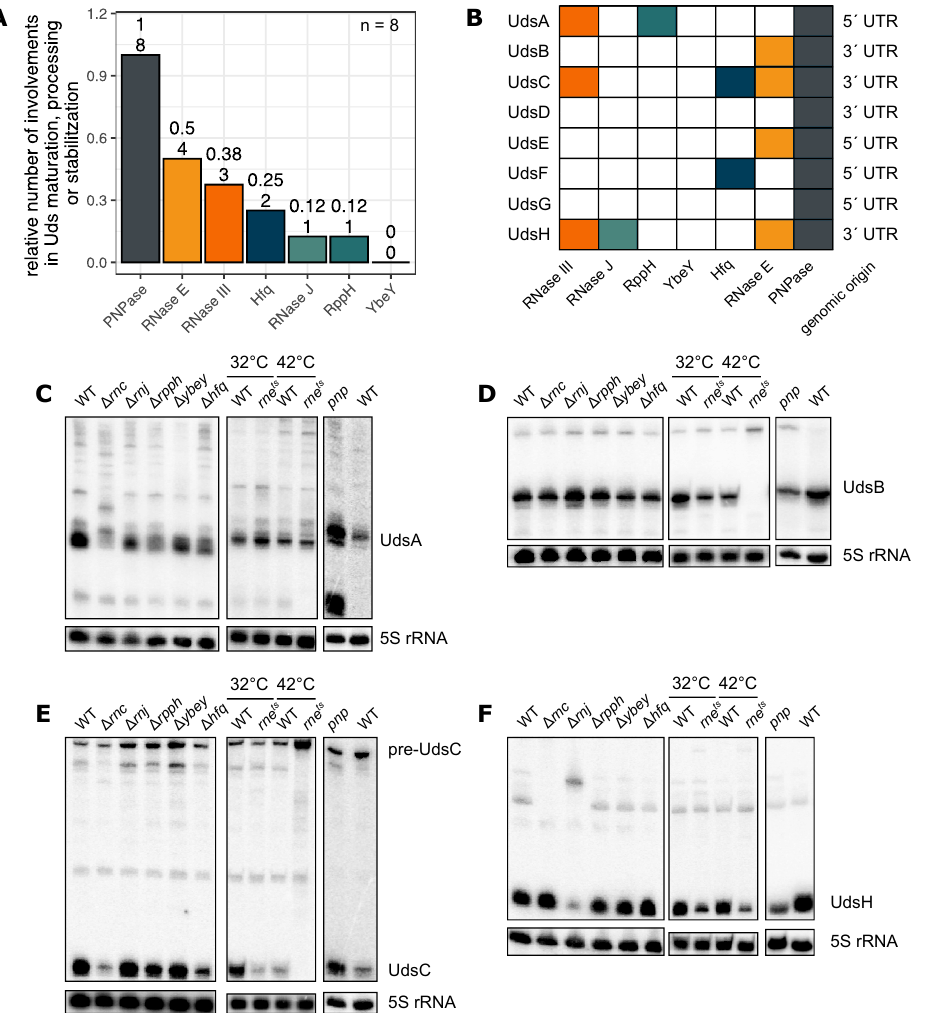
Figure 3. The processing and maturation of UTR-derived sRNAs in R. sphaeroides is influenced by various different enzymes. ( A ) Total RNA was isolated from the depicted strains and analyzed by northern blots. If the processing pattern, the abundance of a precursor RNA or the final sRNA varied comparing the wild type and a mutant strain, the respective enzyme was classified as “involved in Uds maturation, processing or stabilization”. n = 8. Full blots with samples from biological triplicates are shown in Figures S2–S4. ( B ) Summary of the involved enzymes subdivided by individual UTR-derived sRNAs. Colors represent the enzymes also depicted in Figure 3A. ( C – F ) Northern blots illustrating the processing and maturation of UdsA, UdsB, UdsC and UdsH. 10µg of total RNA per lane. 5S rRNA serves as loading control. Northern blot of pnp and wild type